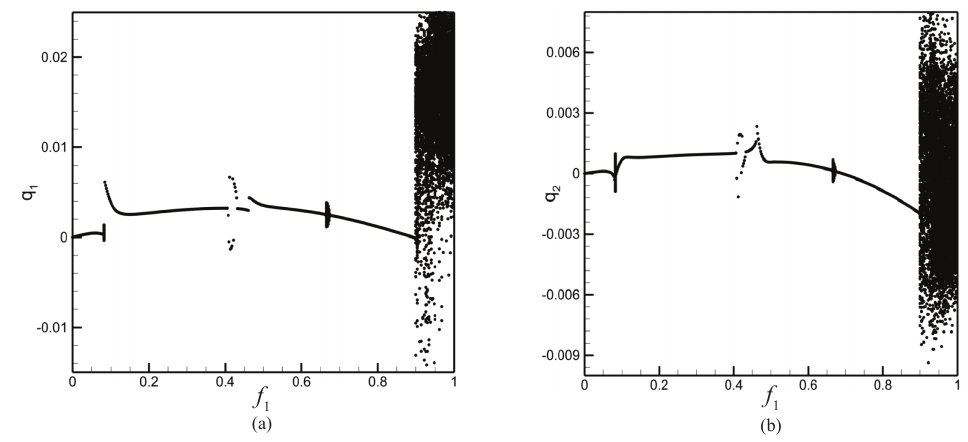
Fig. 17. Bifurcation diagrams of Poincaré points for increasing forcing amplitude on the system with γ T = 0 . 3